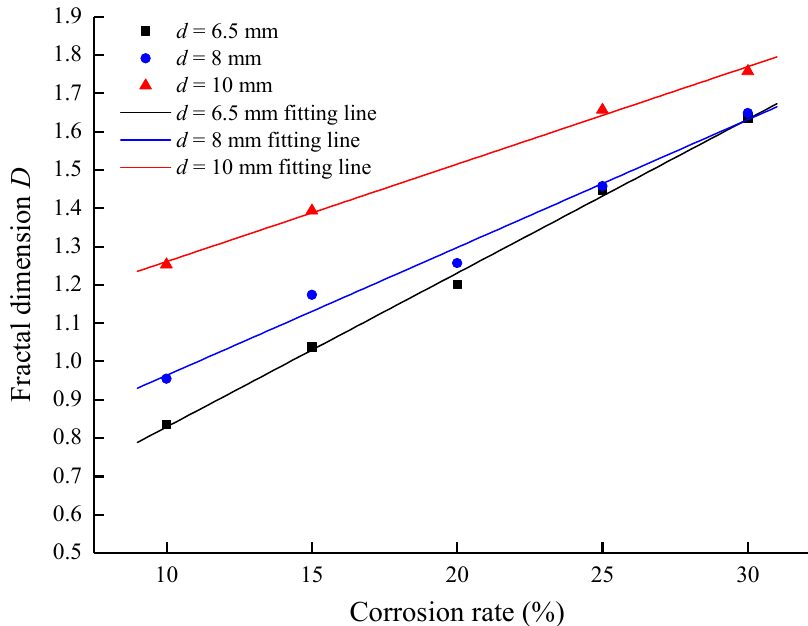
Figure 8. Relationship between fractal dimension and corrosion rate. The scale coefficient C for different steel bar diameters and corrosion rates are shown in Figure 9, where the largest scale coefficient (81,454) corresponds to the 30% corrosion rate of specimen G10-4 specimen, and the smallest scale coefficient (2634) corresponds to the 10% corrosion rate of specimen C6.5-2. The scale coefficient for the black pixel points of the corrosion-induced cracks increased exponentially with the corrosion rate, with an increase of approximately 200% (176–268%) for every 5% increment in the corrosion rate, irrespective of the steel bar diameter. Moreover, as the diameter of the steel bar increased, the scale coefficient increased significantly. These findings suggest that the development of the corrosion-induced cracks is governed significantly by the corrosion degree and steel bar diameter; in fact, this conjecture is supported by the experimental and theoretical analyses of Alonso et al.